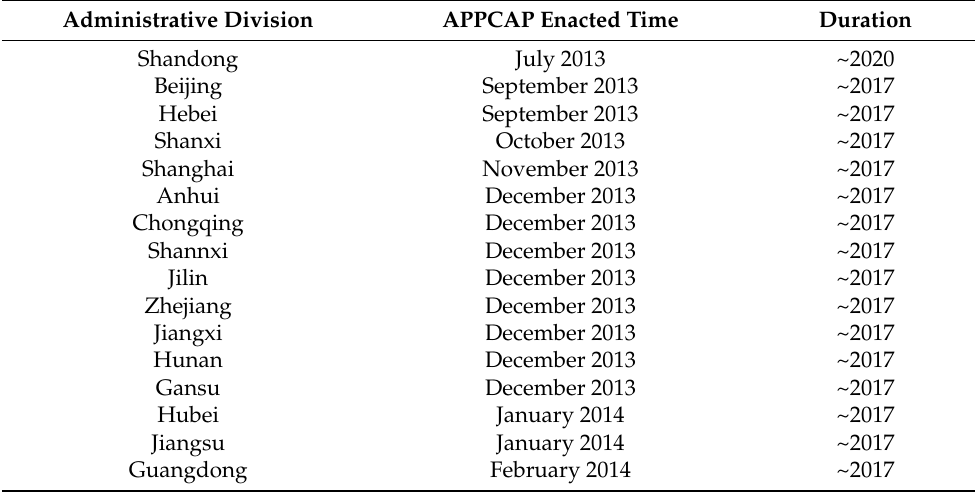
Figure 1. APPCAP implementation time by year. Source : Official website of each administrative division. Table 1. APPCAP implementation time by month and duration.